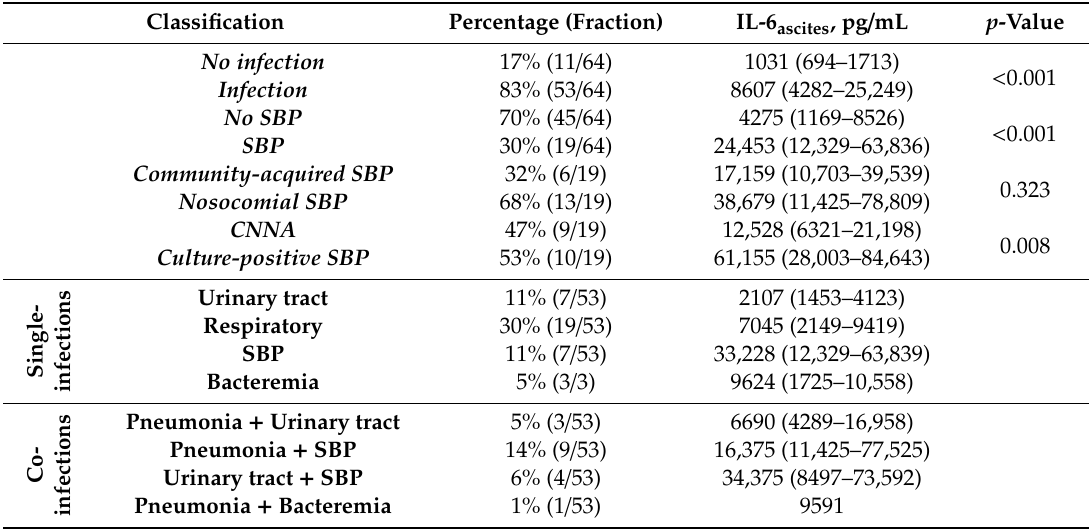
Table 2. Percentage distribution depending on evidence of infection and corresponding levels of ascitic interleukin 6 (IL-6 ascites ) on admission to intensive care unit